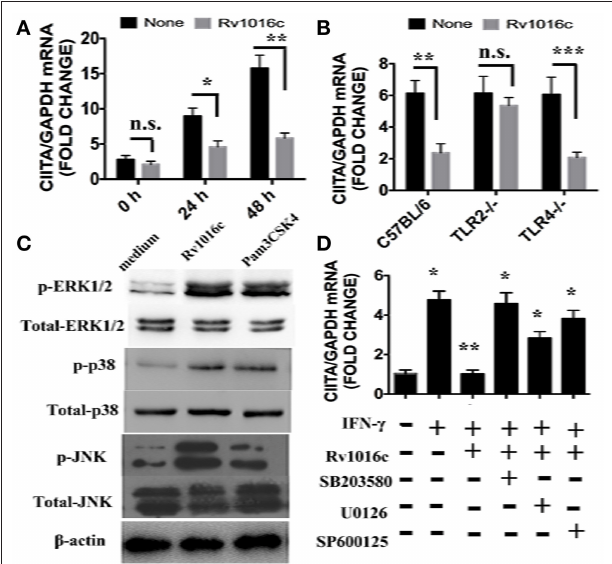
FIGURE 7 | Rv1016c inhibits IFN- γ - induced expression of CIITA dependent on TLR2 and MAPK pathway. (A) THP-1 cells were incubated with or without Rv1016c-His (20 µ g/ml) for 24 h, then with IFN- γ (15ng/ml) in the continued presence or absence of Rv1016c for the indicated times. RNA was isolated, and quantitative real-time PCR was used to analyze the expression of CIITA. (B) Macrophages (1 × 10 6 cells/well) from wild type, TRL2 − / − or TRL4 − / − were incubated with or without Rv1016c-His (20 µ g/ml) for 24 h, then with IFN- γ (15 ng/ml) in the continued presence or absence of Rv1016c-His for the indicated times. The expression of CIITA was measured as previously described. (C) Rv1016c activates MAPKs pathway in macrophages. THP-1 cells were treated with Rv1016c (20 µ g/ml) or Pam3CSK4 (5 µ g/ml) for 1 h, the phosphorylation of p38, ERK (1/2) and JNK were examined by blotting with specific antibodies to p-p38, p38, p-ERK1/2, ERK1/2, p-JNK, and JNK. (D) Rv1016c-mediated inhibition of CIITA expression is dependent on MAPK signaling. Macrophages were incubated with or without DMSO (vehicle control), p38 (SB203580, 10 µ M), ERK (U0126, 10 µ M), or JNK (SP600125, 10 µ M) for 1 h at 37 ◦ C. Rv1016c (20 µ g/ml) was added to samples for the next 6 h, and IFN- γ (15 ng/ml) was added for a final 5 h (presence of inhibitors maintained). Expression of CIITA mRNA was assayed as previously described. All samples were first normalized to GAPDH and are expressed as the fold change compared with untreated controls. All data are expressed as the mean ± SD from three separate experiments. (* p < 0.05, ** p < 0.01, *** p < 0.001 vs. corresponding